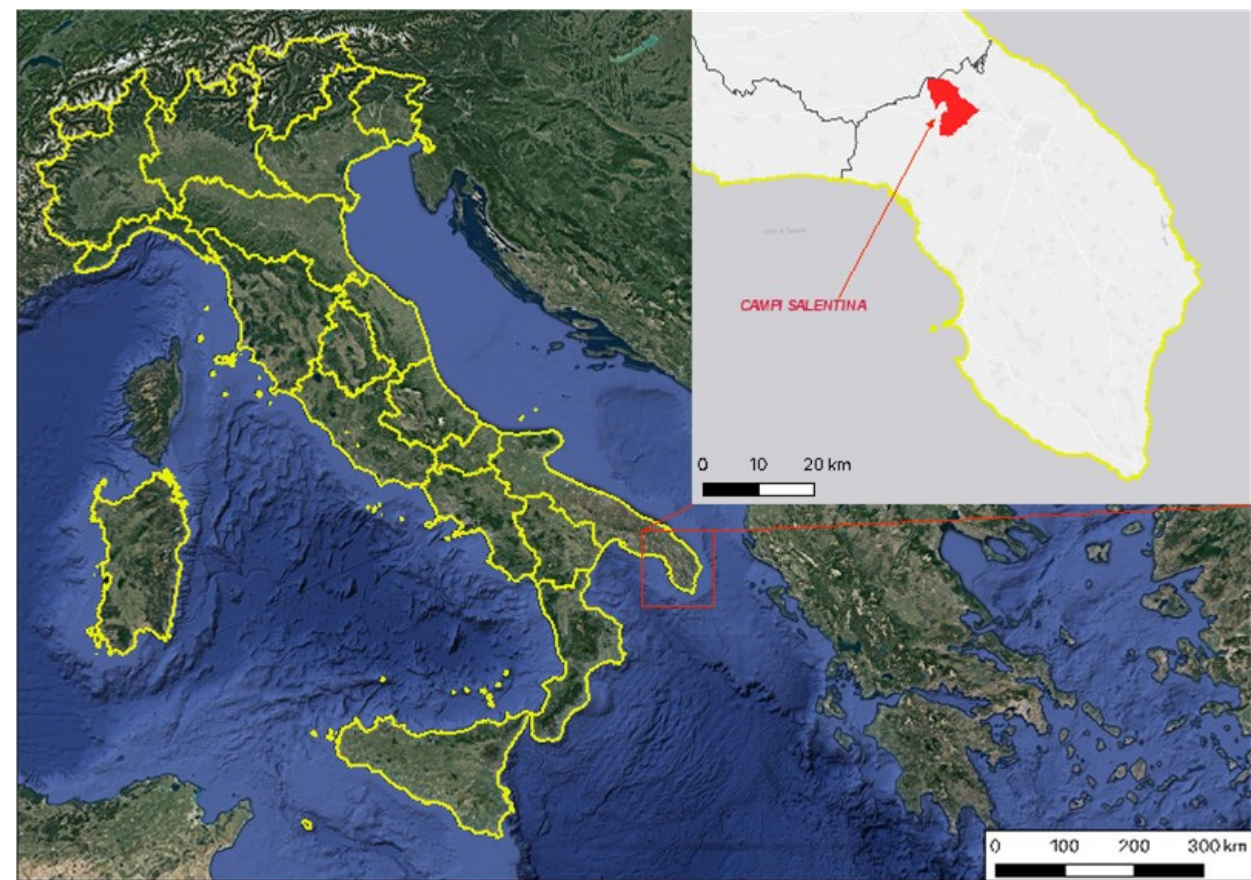
Figure 1. Location of study area.